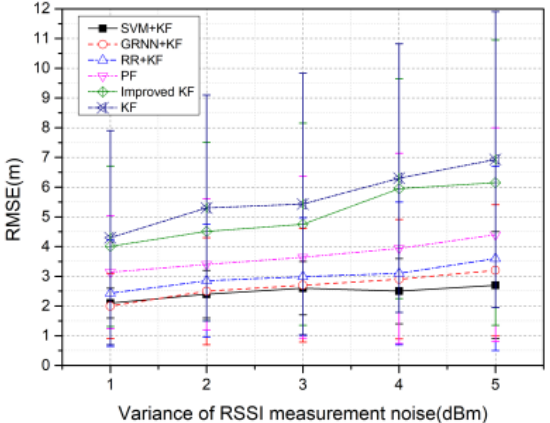
Figure 10. RMSE versus variance of received signal strength indication (RSSI) measurement noise with 100 rounds. Table 6. Parameter